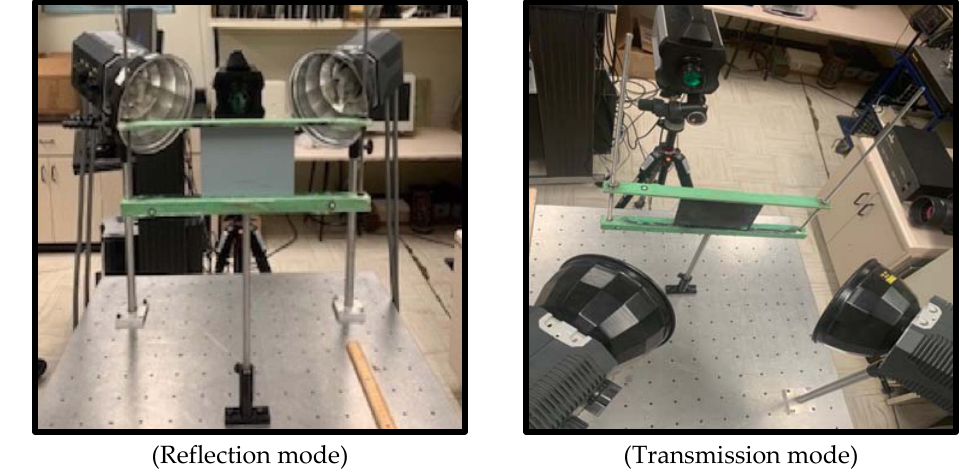
Figure 2. methods for image capture. Figure 2. Methods for image